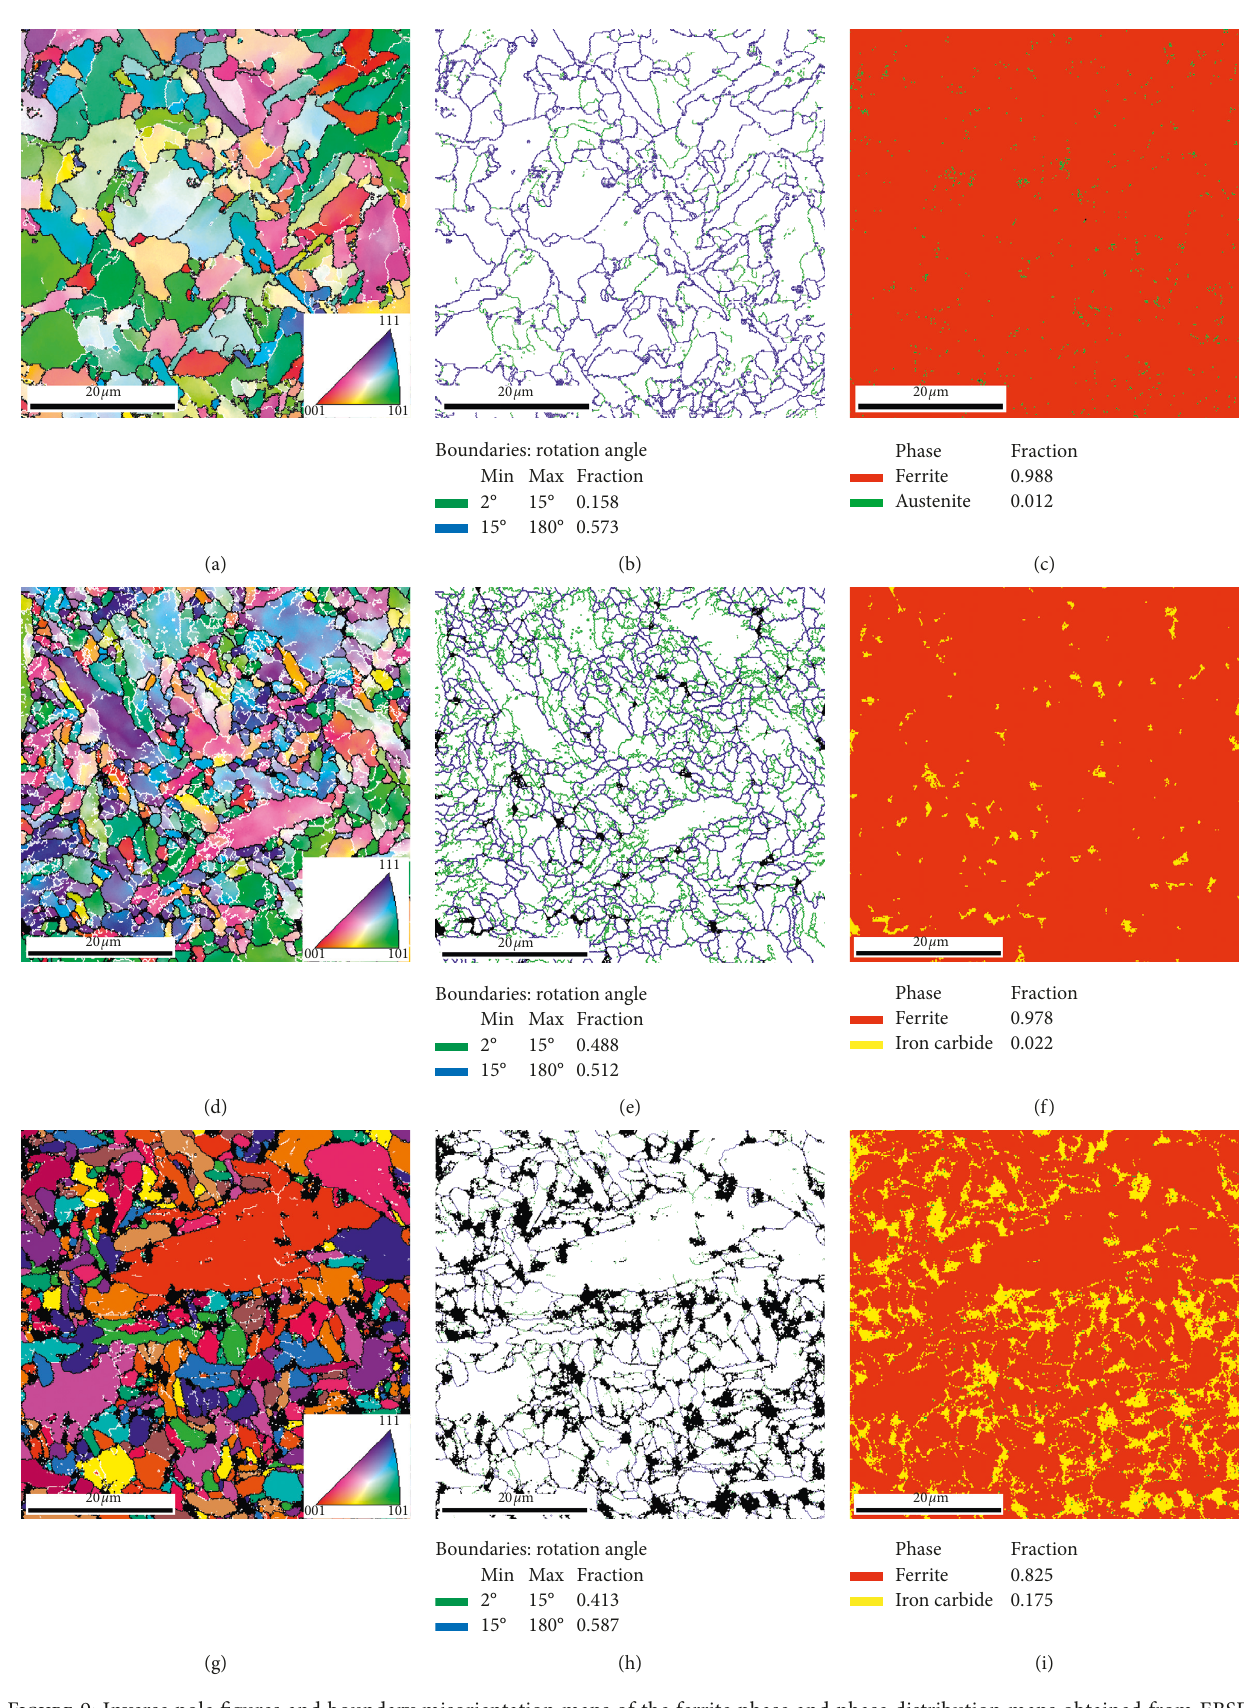
Figure 9: Inverse pole figures and boundary misorientation maps of the ferrite phase and phase distribution maps obtained from EBSD measurement of Bend C after tempering at different temperatures: (a)–(c) 550 ° C; (d)–(f) 620 ° C; (g)–(i) 680 °